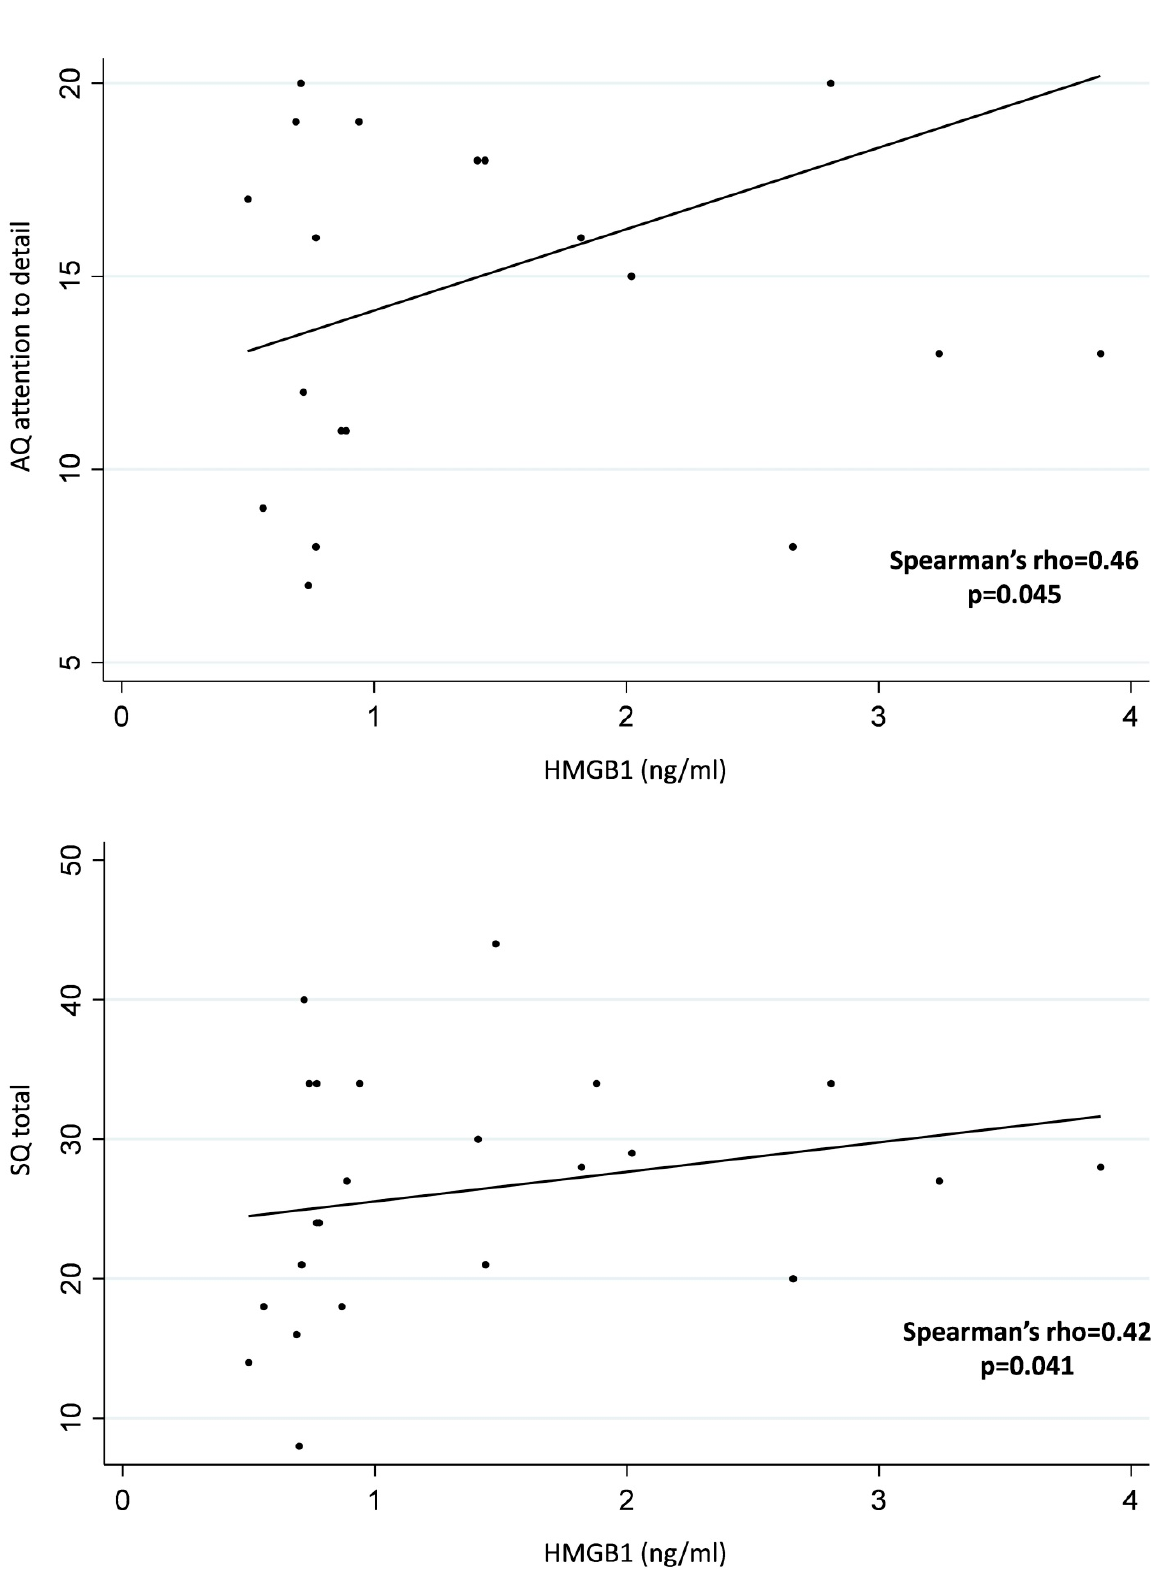
Figure 2. Positive associations between HMGB1 serum concentrations and AQ attention to detail and SQ total scores in ASD children.